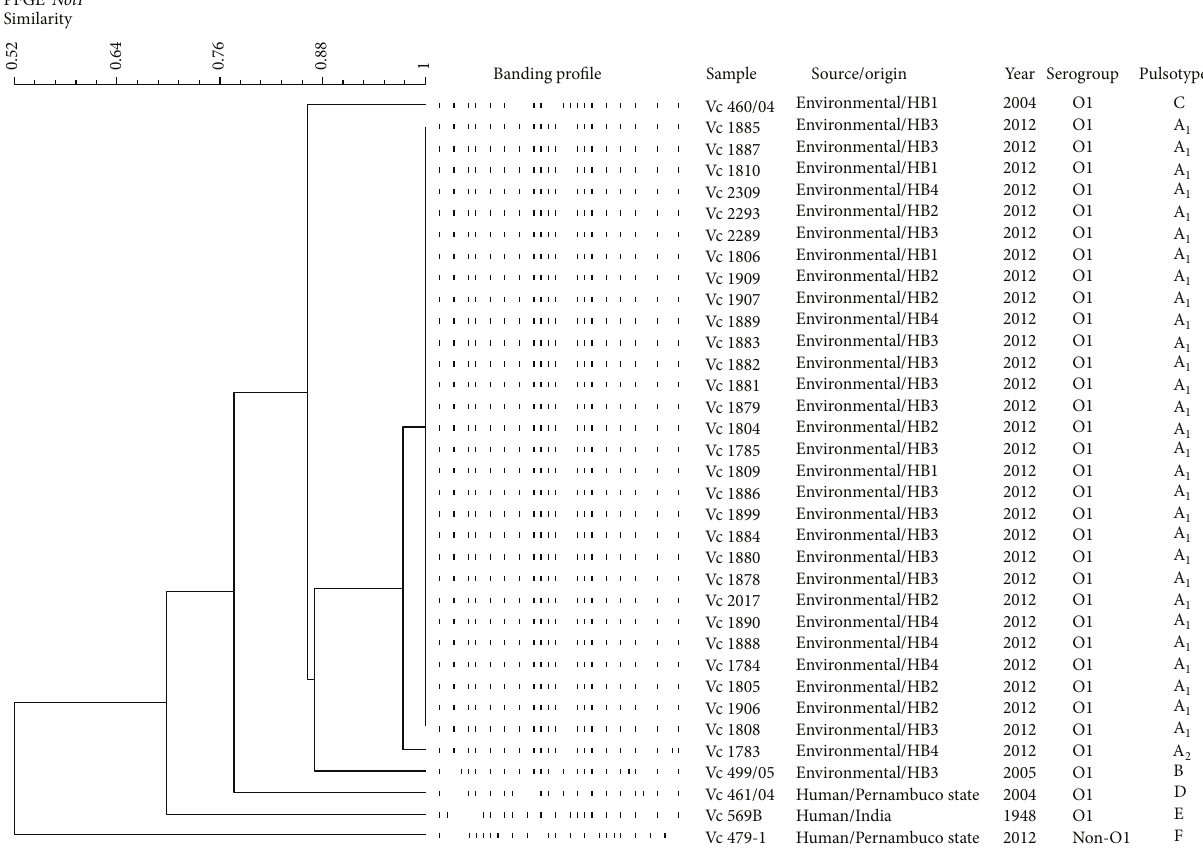
Figure 2: Dendrogram generated by Dice/UPGMA analysis (NTSYS v.2.11X, Applied Biostatistics) of PFGE Not I profiles of Vibrio cholerae isolates. HB1: Capibaribe hydrographic basin, HB2: Goiana hydrographic basin, HB3: Ipojuca hydrographic basin, HB4: Munda´u hydrographic